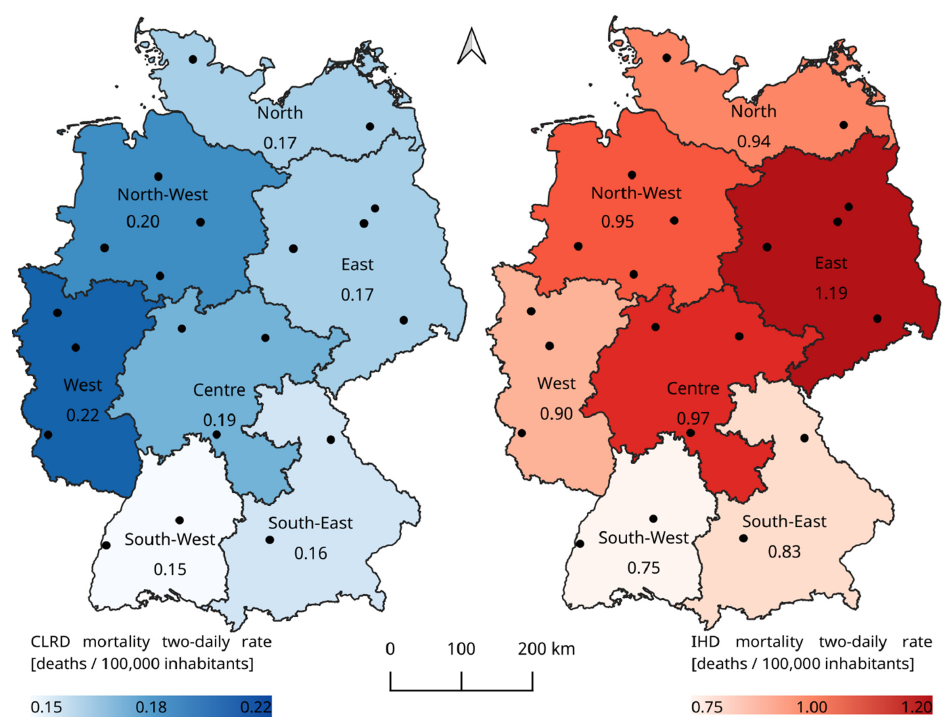
Figure 1. Spatial resolution and two-daily rate (two-daily sum of deaths per 100,000 inhabitants) of chronic lower respiratory diseases (CLRD) mortality (J40–J47, blue, left) and ischemic heart diseases (IHD) mortality (I20–I25, red, right) data in seven regions in Germany. The black dots display the locations of 20 meteorological stations.